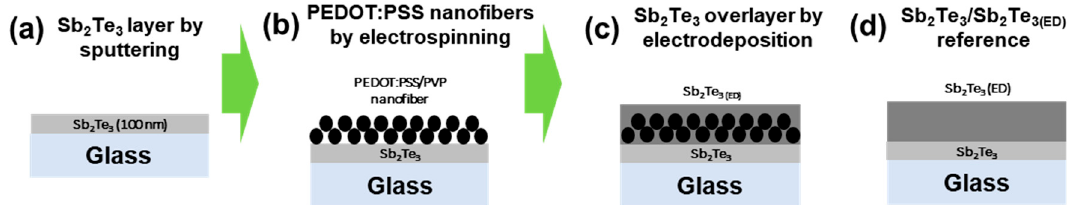
Figure 1. ( a – c ) Schematic illustration of fabrication process for PEDOT:PSS-embedded Sb 2 Te 3 films composed of sequentially coated Sb 2 Te 3 (sputtering), PEDOT:PSS-PVP (electrospinning), and an Sb 2 Te 3 overlayer (electrodeposition, ED). ( d ) A reference sample without PEDOT:PSS-PVP was also fabricated.